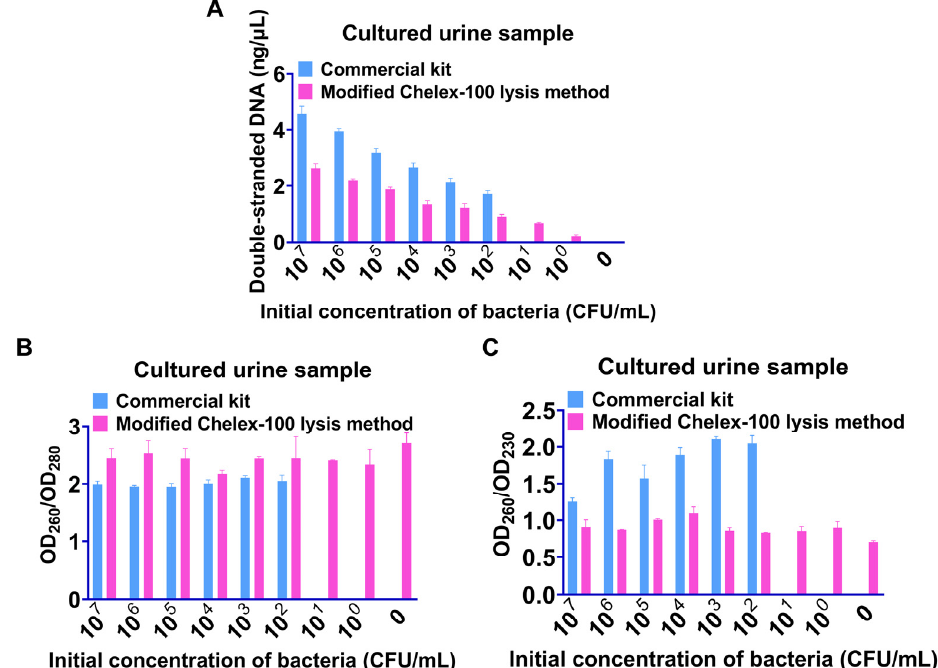
Figure 3. Comparison of the refined Chelex-100 lysis method with commercial kits applied in cultured bacterial-containing urine. ( A ) concentration of DNA, ( B ) OD 260 /OD 280 value, ( C ) OD 260 /OD 230 value.